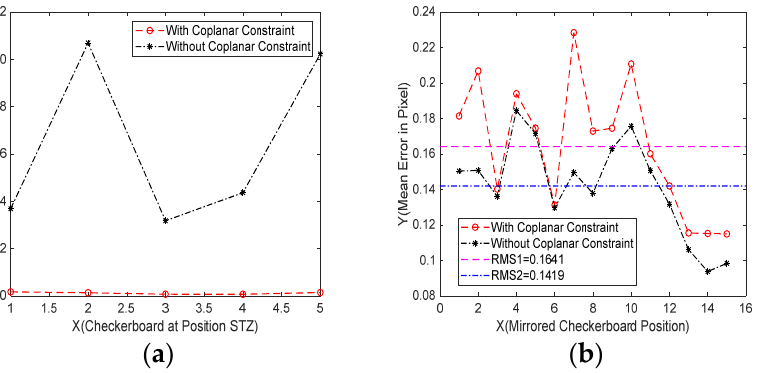
Figure 8. Comparison of error with and without constraints. ( a ) Coplanarity error of the two meth-